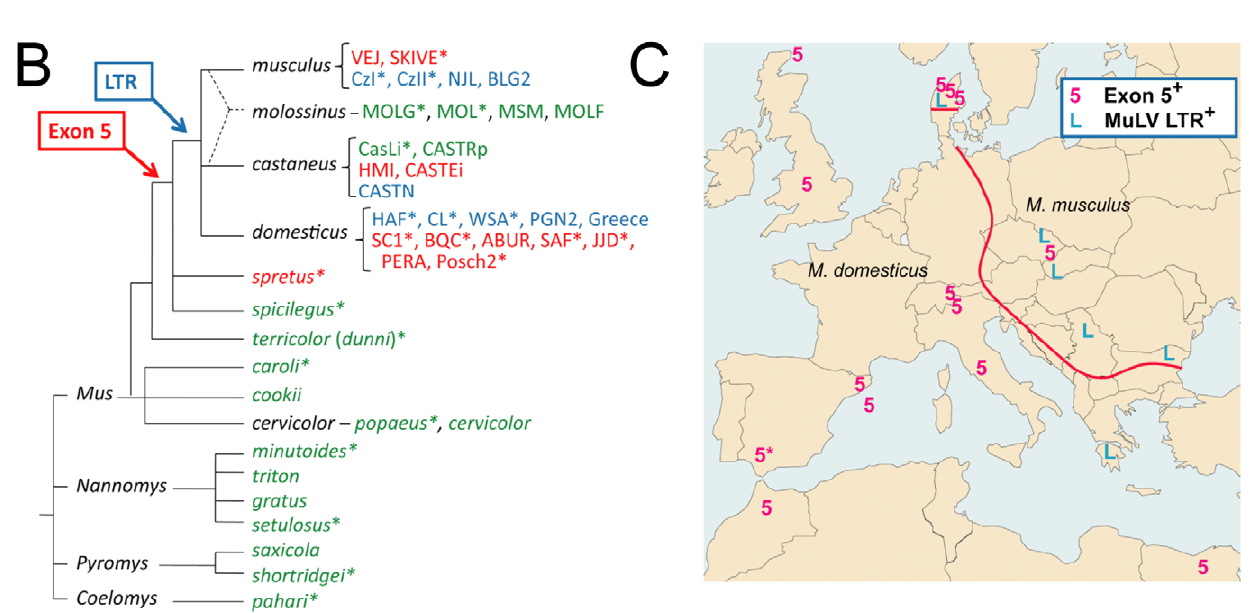
Figure 9. Distribution of sequence variations in and around the Apobec3 exon 5 in Mus species and strains. (A) The Apobec3 genomic sequences of the indicated strains and representative species are shown. The five SNP tested for their effects on exon 5 splicing are indicated with shaded bars. Also shown are the number of TCCT repeats and typing results indicating the presence or absence of exon 5 (Ex5) in spliced messages and the presence or absence of an MuLV LTR in intron 2. (B) The phylogenetic tree is a synthetic tree adapted from other sources [66–68]. Species are grouped into the 4 Mus subgenera and are listed to the right of each branch. Subspecies and stock or inbred line designations are given where multiple samples of a given species were tested. Red, exon 5 + /MuLV LTR 2 ; blue, D 5/MuLV LTR + ; green, D 5/MuLV LTR 2 . *, mice tested for exon 5 splicing pattern. All were sequenced across exon 5 (Figure S1); PERA and MOLF sequence information was taken from Okeoma et al. [38]. (C) Distribution of expression variants of mA3 in mice trapped in Europe. The red line represents the 20 km-wide hybrid zone separating the ranges of M. domesticus and M. musculus . Symbols representing mA3 allelic variants are placed at trapping sites.